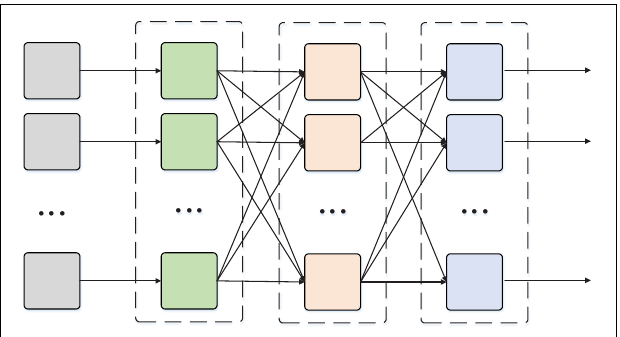
FIGURE 1 | RNN structure diagram.